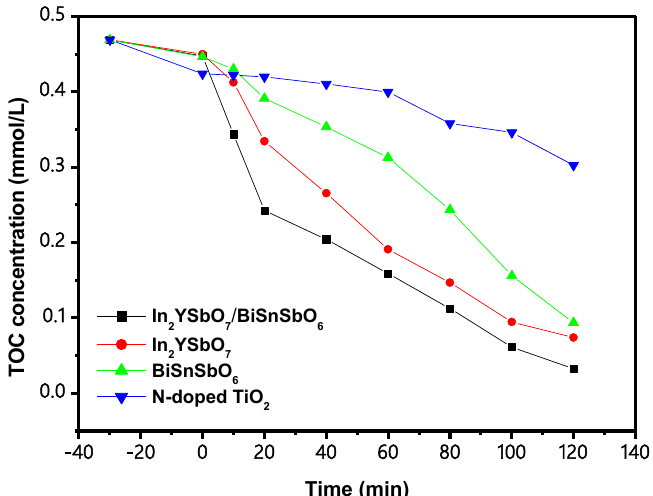
Figure 17. Concentration variation curves of TOC during PCD of IC in DW with IBH as a catalyst or with In 2 YSbO 7 as a catalyst or with BiSnSbO 6 as a catalyst or with N-TiO 2 as a catalyst under